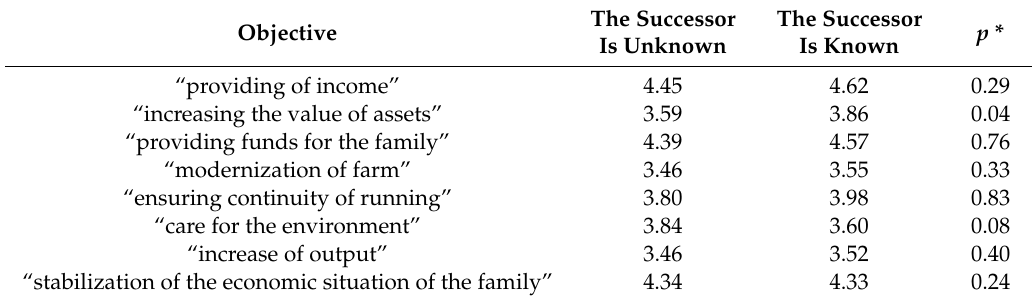
Table 4. The preferences of the managers of the surveyed agricultural holdings for the objectives of operations of the agricultural holdings due to the existence or not of a